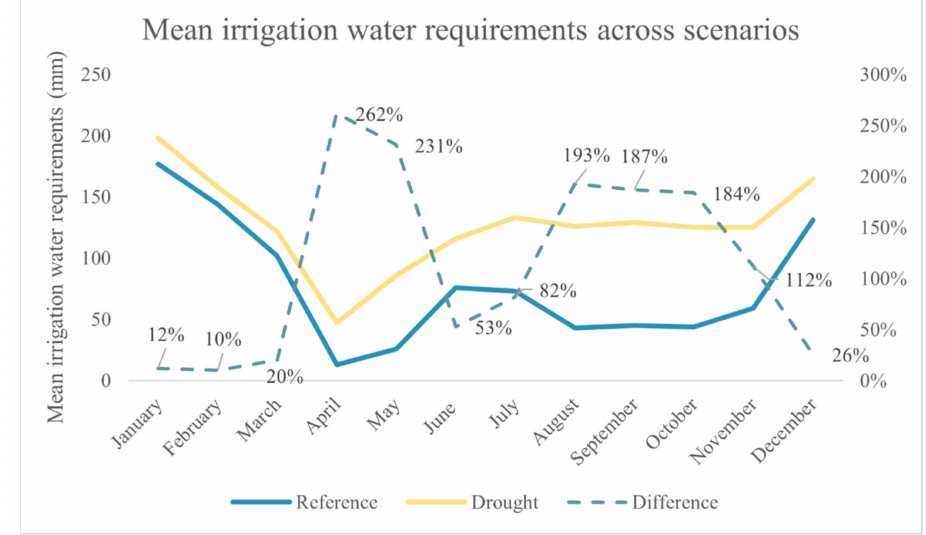
Figure 11. Monthly mean irrigation requirements (mm) in the reference and the drought scenario. The dashed line represents the difference in percentage between the reference and the drought scenario.